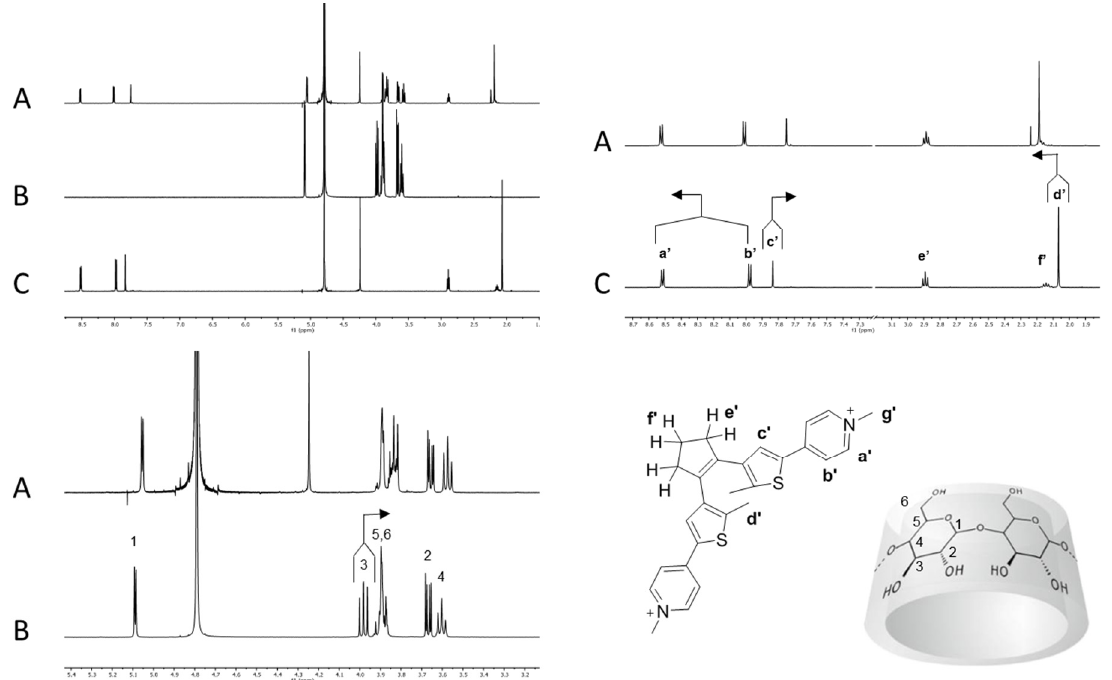
Figure 3. Host–guest interaction between β -CD and photochrome 2o . ( A ) 2o (7.00 ∙ 10 − 3 M) + β -CD (7.00 ∙ 10 − 3 M) in D 2 O; ( B ) β -CD (7.00 ∙ 10 − 3 M) in D 2 O; ( C ) 2o (7.00 ∙ 10 − 3 M) in D 2 O.